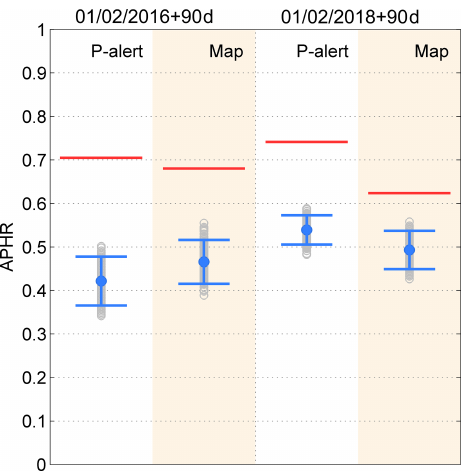
Figure 4. Performance test of APHR. The red line indicates the forecasts of real-time PSHA, the gray circle indicates the result of a random test by randomly redistributing seismic intensities, and the blue error bar indicates the interval with 2 standard deviations over all random